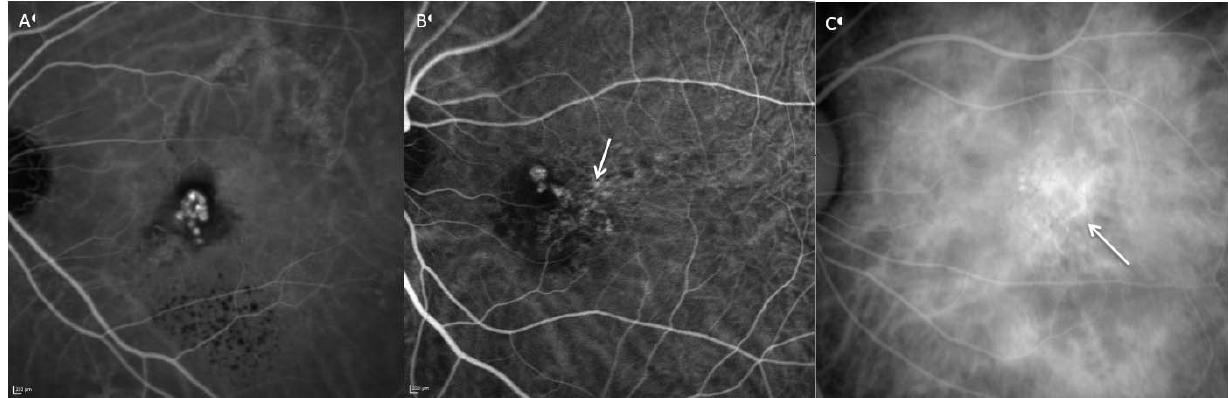
Figure 2. Angiographic patterns of PCV: Cluster of grapes configuration ( A ), solitary ( B ) and string of pearls ( C ). Branching vascular networks (white arrow) are seen in figure B and